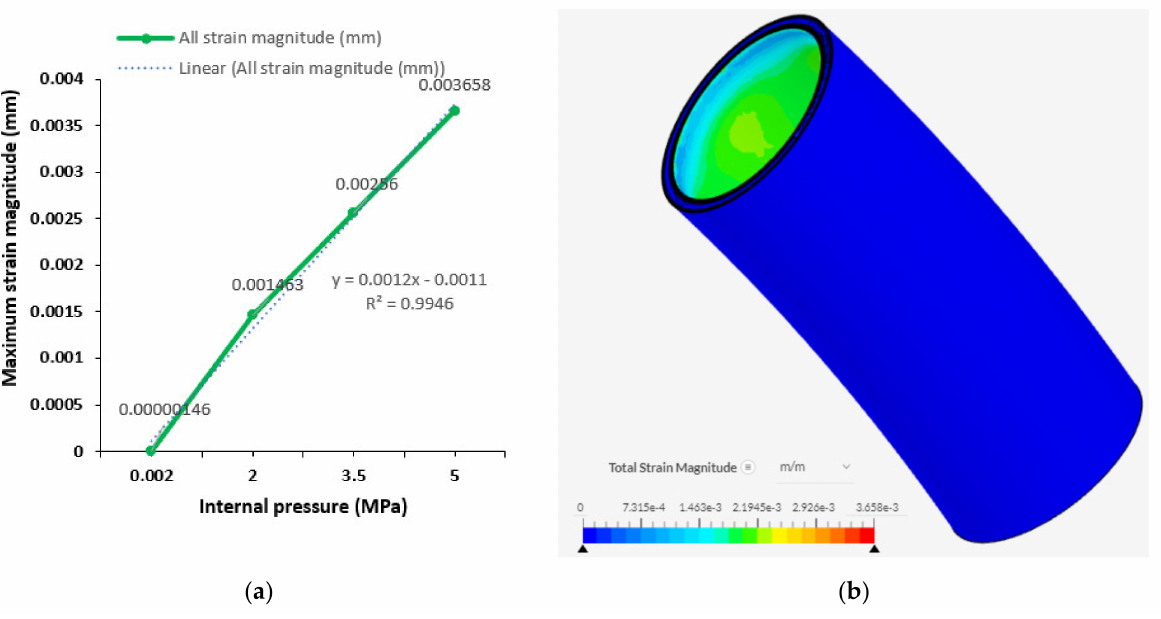
Figure 16. Strain Profile of the bonded flexible hose under internal pressure, showing ( a ) the maximum strain magnitude under internal pressure at 5 MPa, and ( b ) Total strain magnitude of the